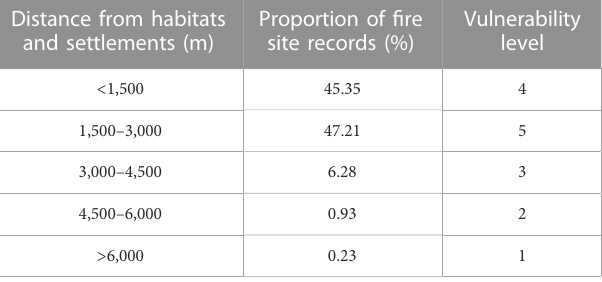
TABLE 5 Classi fi cations of distance from habitats and settlements. Distance from habitats and settlements (m)